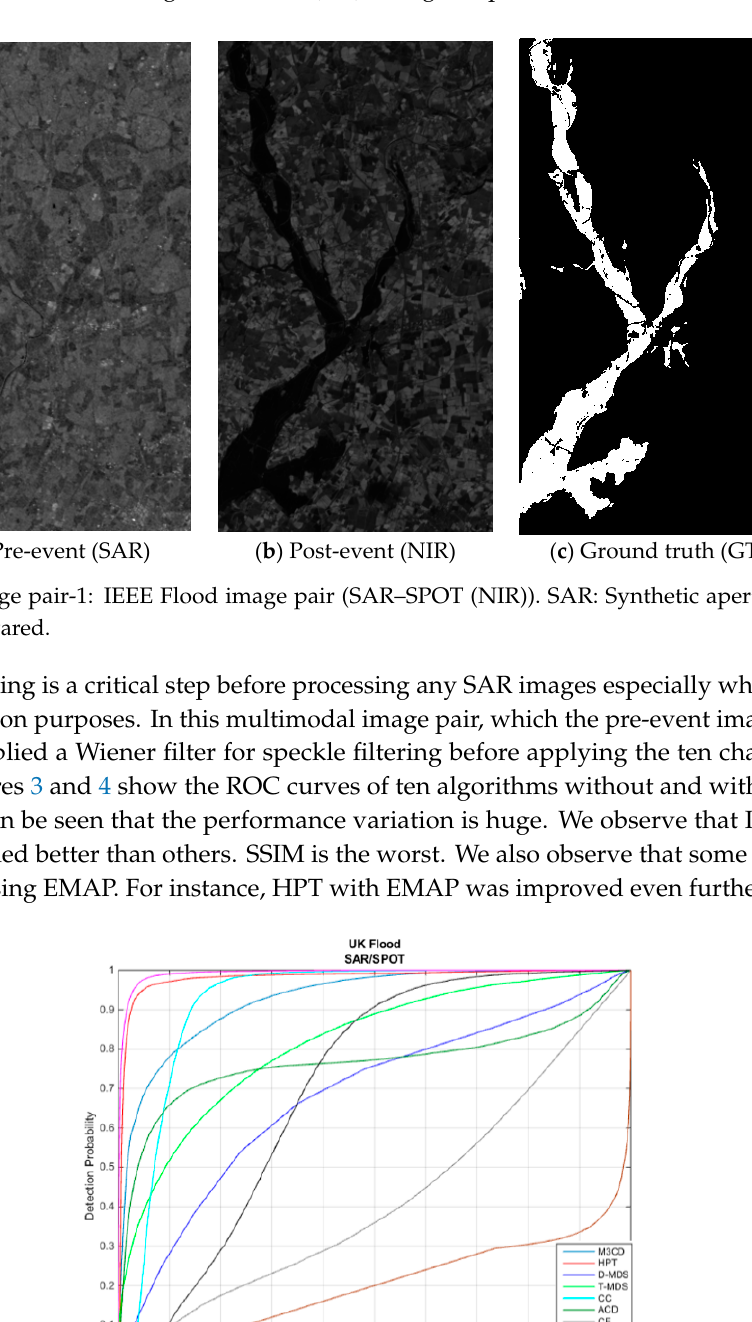
Figure 4. ROC curves for Image Pair-1 (SAR/SPOT) with EMAP. Table 2. Area under curve ( AUC) values and differences between single band and EMAP cases for dataset-1. Bold numbers indicate the best performing method in each column. M3CD: Markov Model for Multimodal Change Detection; HPT: Homogeneous Pixel Transformation; D-MDS: Direct approach; T-MDS: Single band approach; CC: Chronochrome; CE: Covariance Equalization; ACD: Anomalous Change Detection; IR: Image Ratioing; PP: Pixel Pair; SSIM Structural Similarity. Method